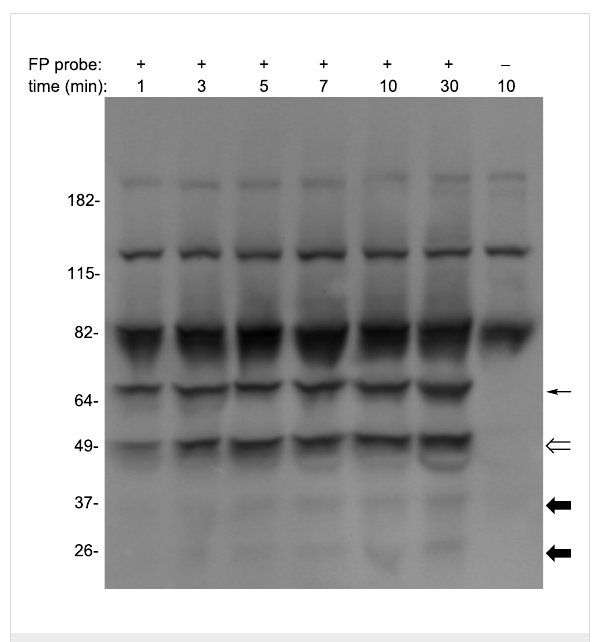
Figure 3: Kinetic study on FP labelling reactions. Caco-2 cell homogenates (1 mg/mL) were treated at room temperature with FP–PEG–biotin 1 (4 μ M) for the indicated times, followed by the termi- nation of reaction with 5× SDS-PAGE loading buffer. The results were analysed by 4–20% SDS-PAGE gel and streptavidin blotting. Serine hydrolases that reacted with the FP probe in a time-dependent manner are highlighted (thin, hollow and dark arrows,